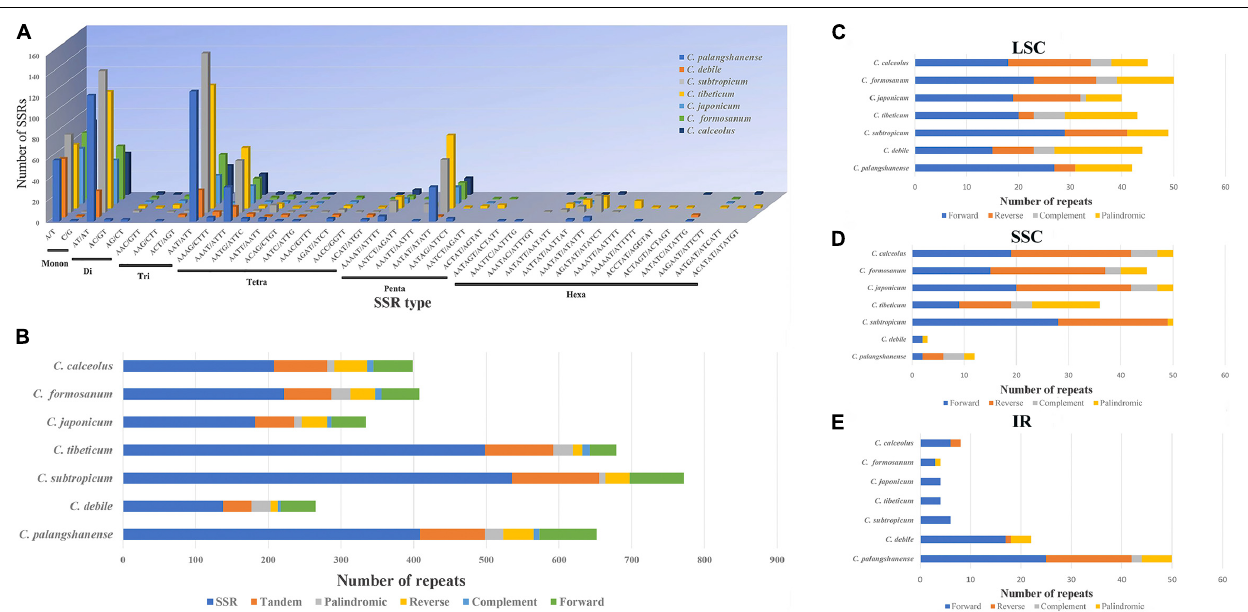
FIGURE 4 | Analyses of repeat sequences in seven chloroplast genomes. (A) Number of different SSRs types. (B) Number of SSRs, tandem repeats and large LSRs. (C) Number of different LSRs types in the LSC regions. (D) Number of different LSRs types in the SSC region. (E) Number of different LSRs types in the IR